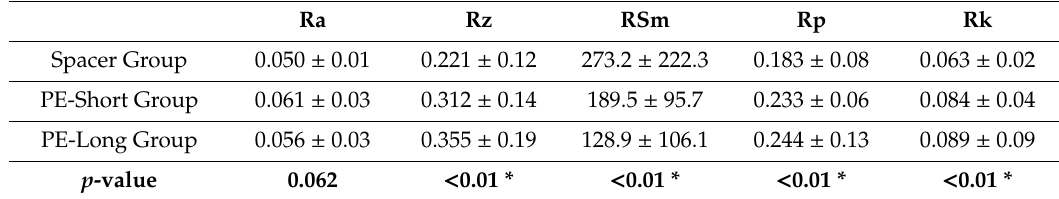
Table 5. Comparison of roughness parameters between the spacer group and two conventional hip arthroplasty revision groups (PE-Group Short = short implant time in situ, PE-Group Long = long implant time in situ).